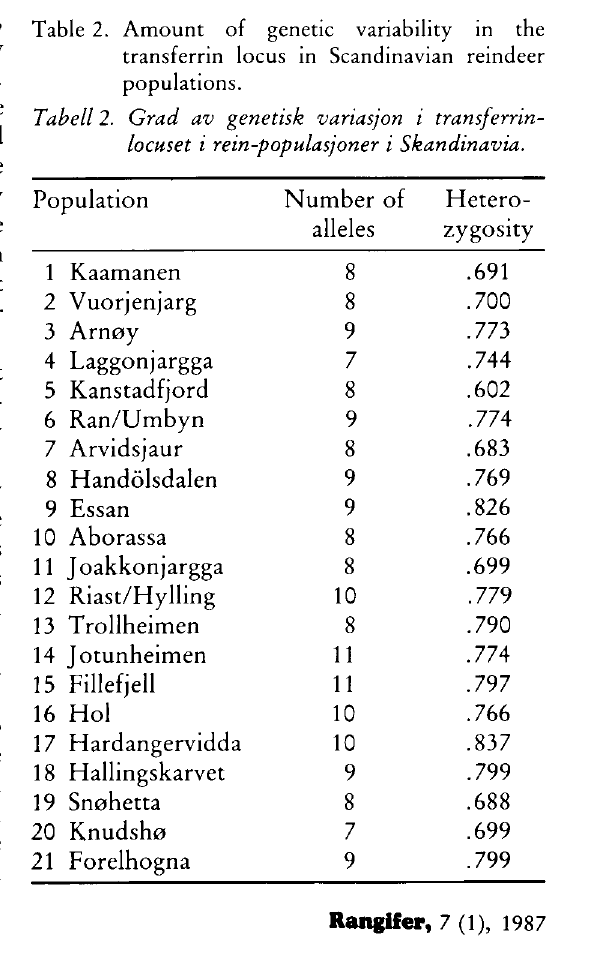
Fig. 2. Transferrin fenotyper hos rein undersøkt ved hjelp av vertikal poly akrylamid gel elektroforese.